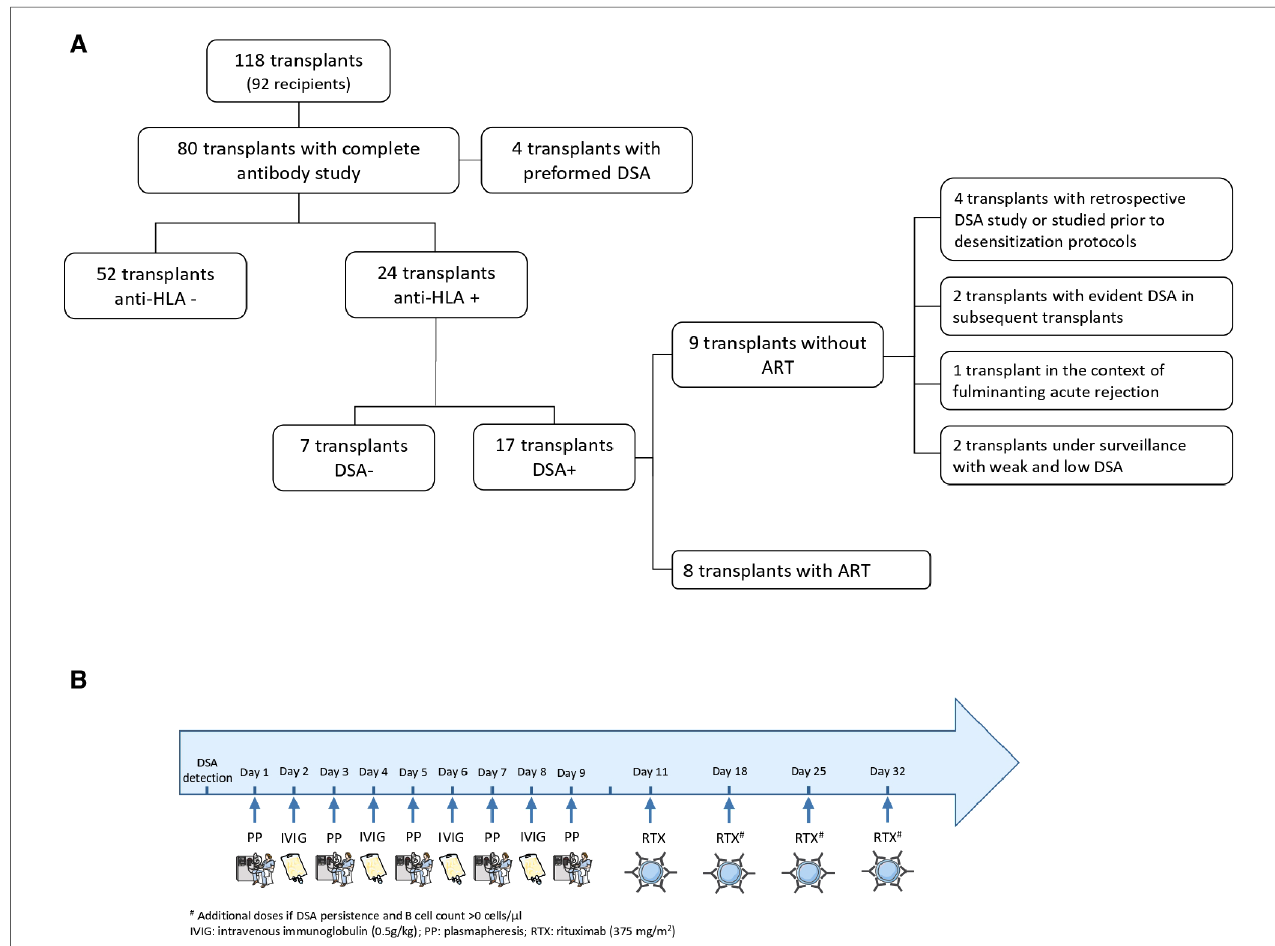
FIGURE 1 ( A ) Description of the studied cohort. ( B ) Antibody-removal protocol for de novo